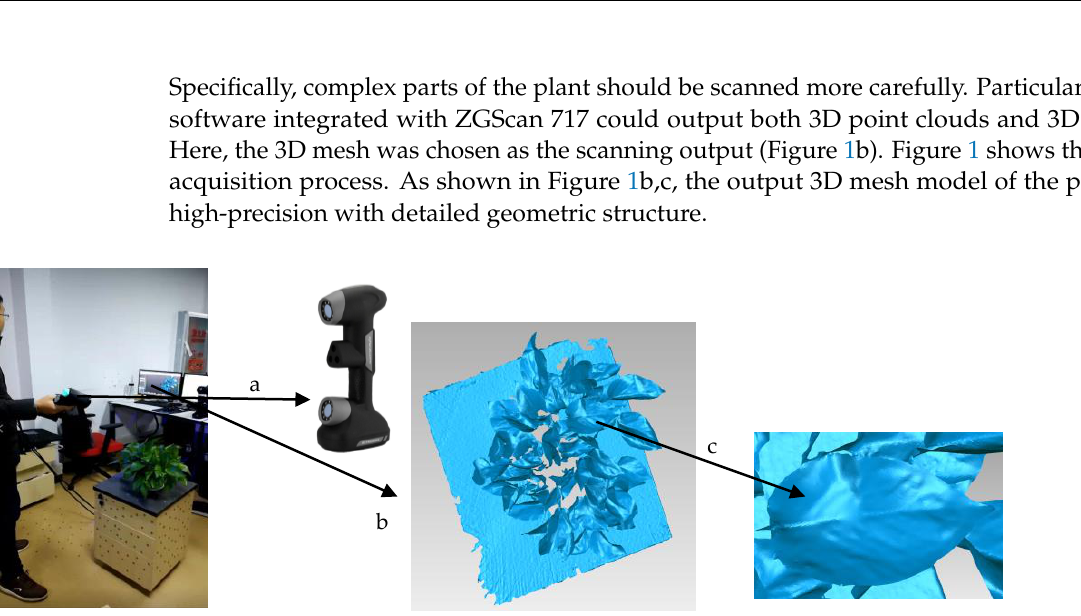
Figure 1. Data acquisition process. ( a ) ZGScan 717; ( b ) The generated 3D mesh model of the plant; ( c ) The 3D mesh model of a leaf. Table 1. Parameters of ZGScan 717.